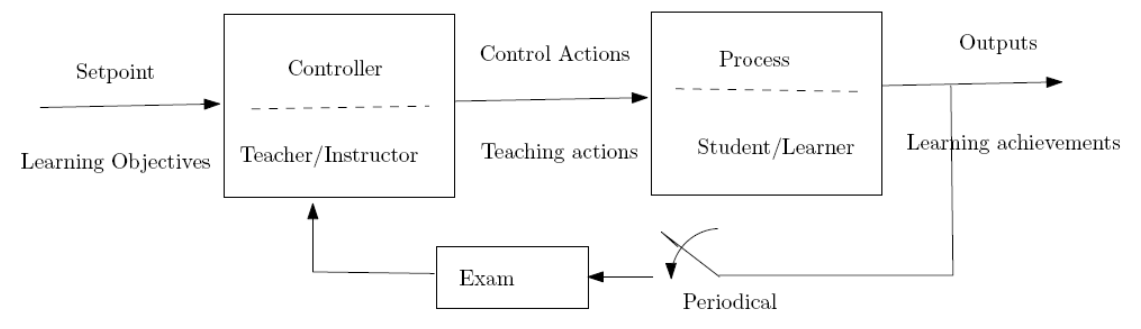
Fig. 3: Closed-loop instructional/control